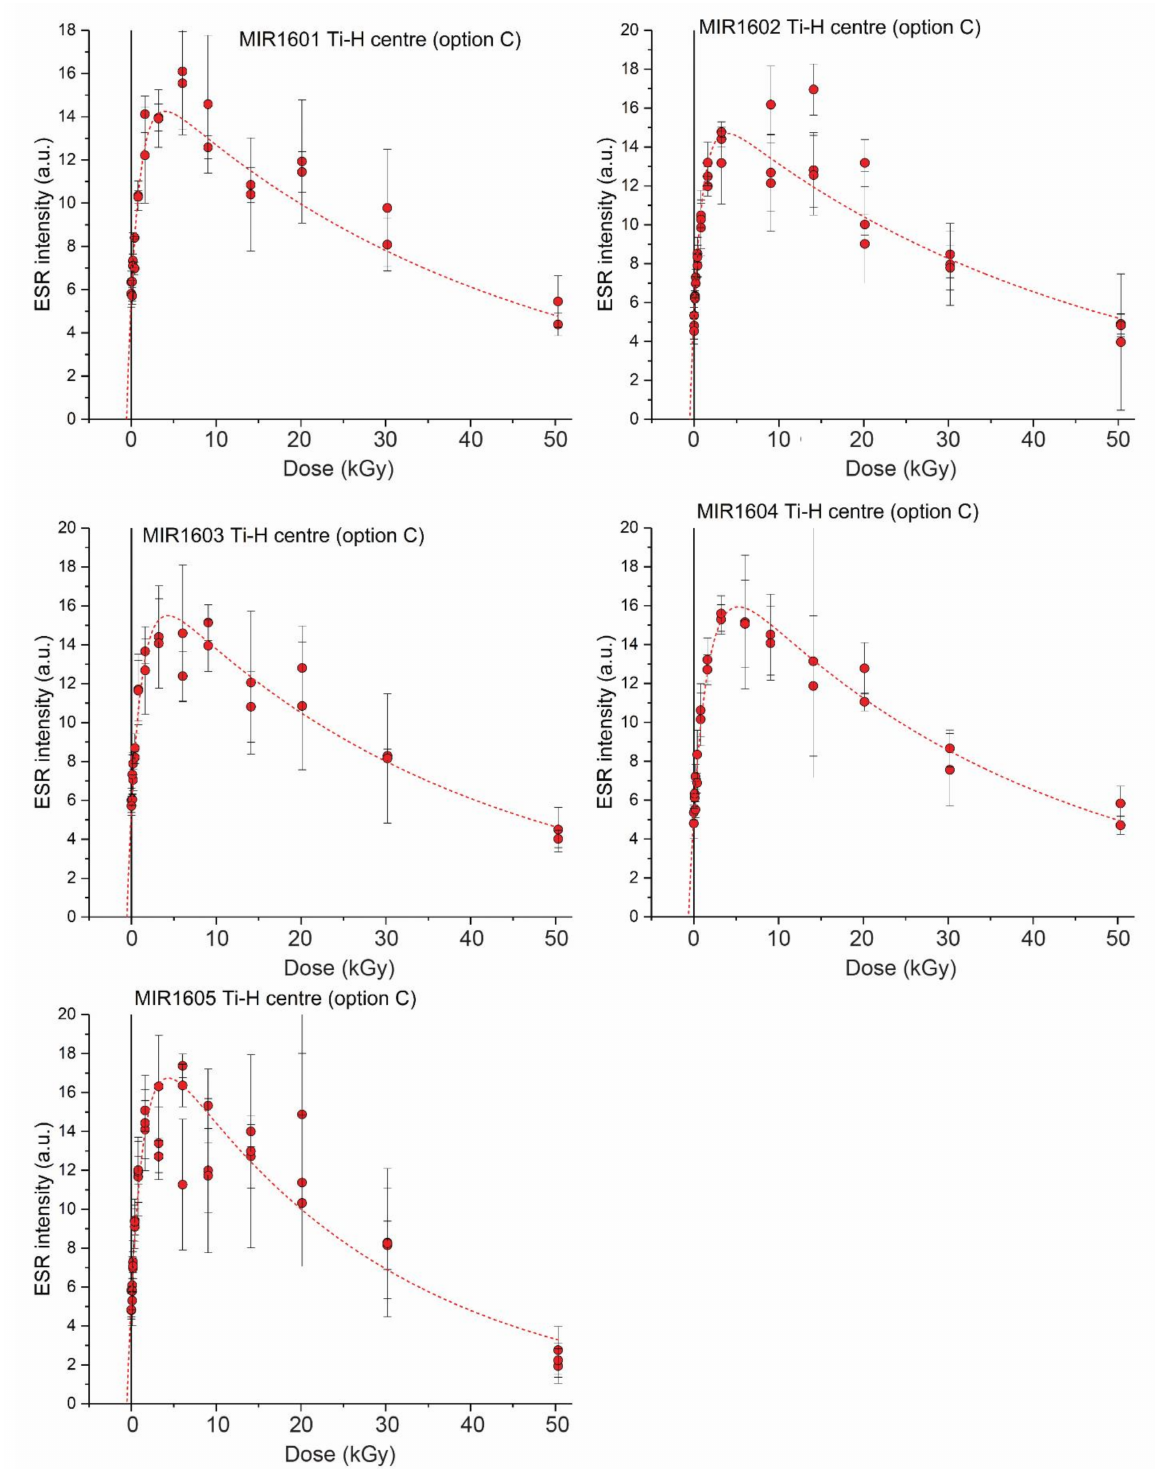
Figure 5. ESR dose response curves (DRCs) of Ti-H center (option C) obtained for five samples dated in present work. All ESR intensities derived from repeated ESR measurements were pooled for fitting. Vertical error bars represent experimental errors associated with ESR intensities, corresponding to 1 standard